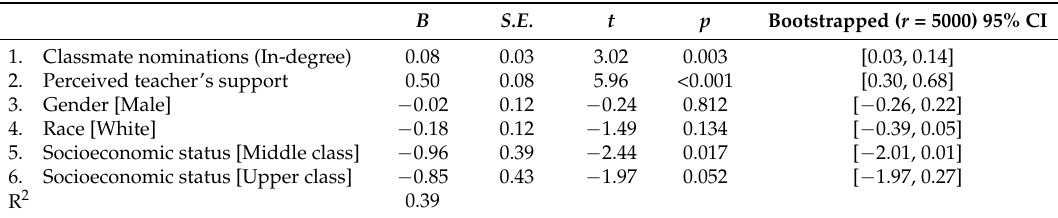
Table 3. Linear regression model results using bootstrapped method ( r = 5000). The reference group of students’ perceived family socioeconomic status was lower